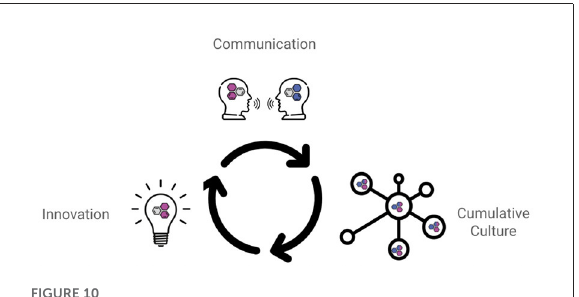
FIGURE10 The circular dynamics of cultural